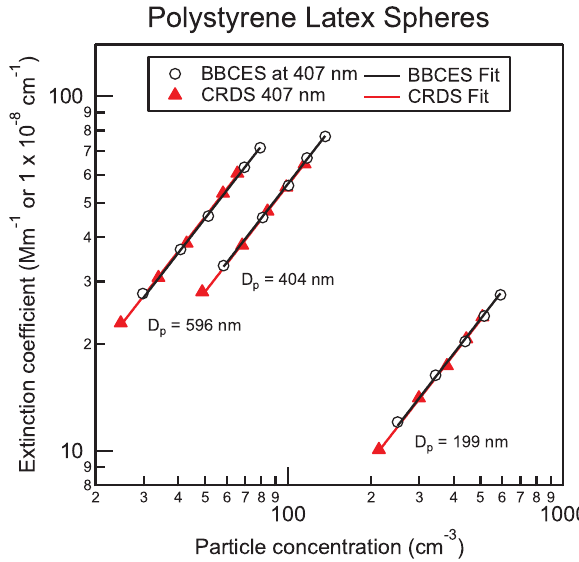
Fig. 2. Extinction coefficients as a function of particle con- centration for polystyrene latex spheres (PSL) at 199, 404, and 596nm diameters. CRDS measurements at λ = 407nm (red triangles) are shown together with the measurements from a single wavelength element ( λ = 407 . 025nm) of the BBCES (black circles). The extinction cross sections calcu- lated from linear fits to each diameter are σ CRDS = 4 . 73 ( ± 0.05) × 10 − 10 cm 2 and σ BBCES =4.70 ( ± 0.02) × 10 − 10 cm 2 at D p = 199nm; σ CRDS = 5 . 68 ( ± 0.04) × 10 − 9 cm 2 and σ BBCES = 5 . 66 ( ± 0.01) × 10 − 9 cm 2 at D p = 404nm; and σ CRDS = 9 . 26 ( ± 0.07) × 10 − 9 cm 2 and σ BBCES = 9 . 05 ( ± 0.03) × 10 − 9 cm 2 at D p = 596nm.